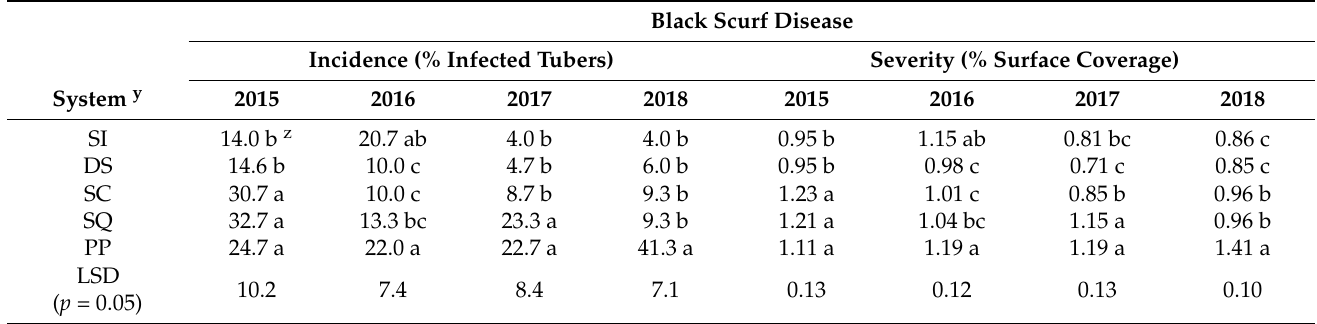
Table 4. Effect of different cropping systems on development of black scurf (caused by Rhizoctonia solani ) on potato tubers over four field seasons (2015 – 2018).